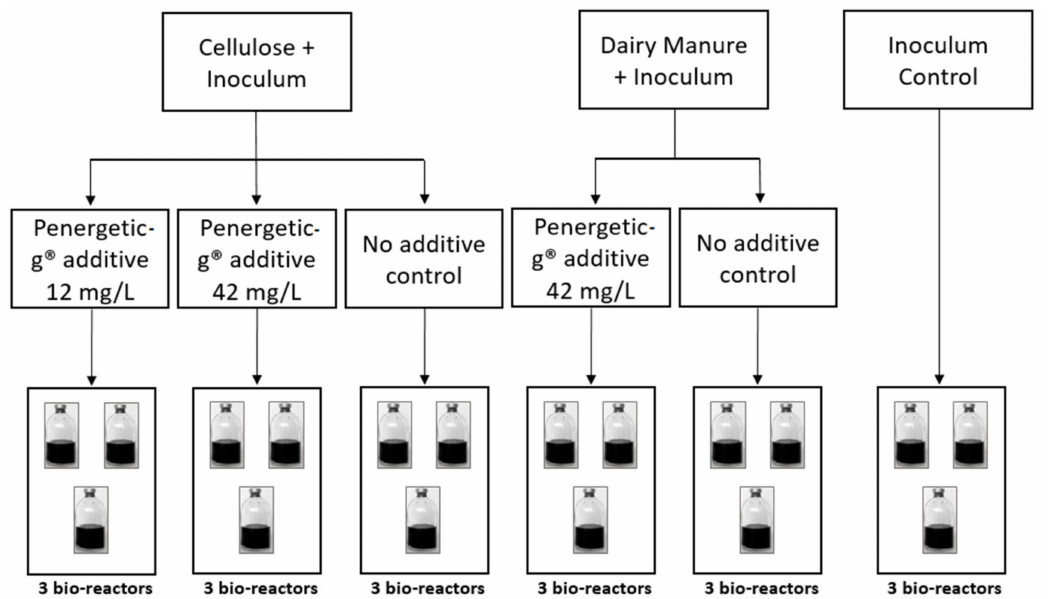
Figure 1. Biochemical methane potential (BMP) trial set-up with 18 bioreactors in InnoTech Alberta’s batch culture set-up. Each additive treatment, the positive control (no additive), and the inoculum control were done in